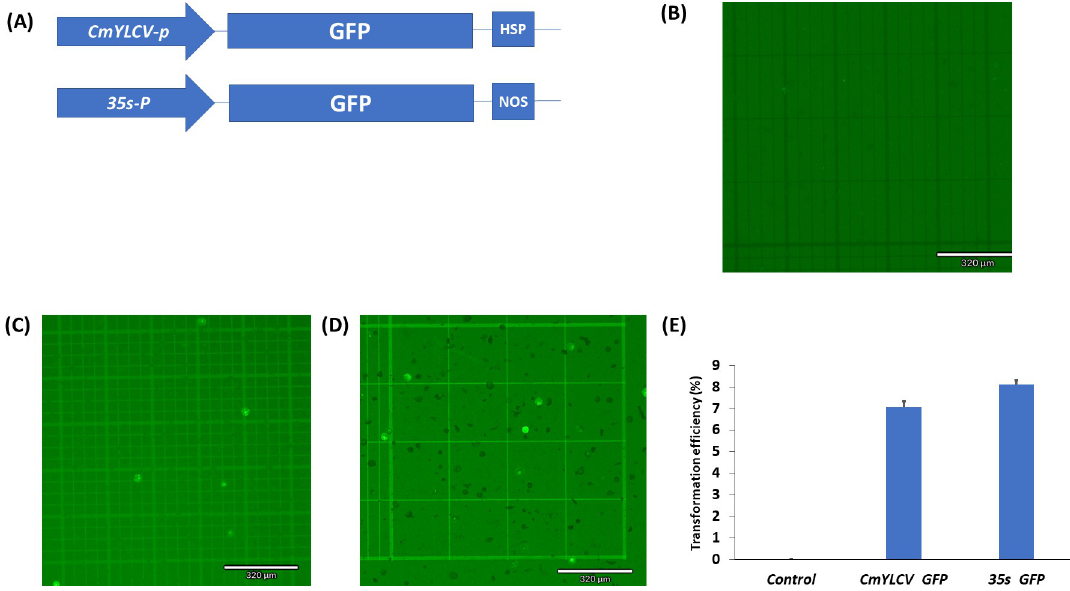
Fig 2. GFP expression under CmYLCV and 35S promoter in cowpea protoplasts. (A) CmYLCV promoter :GFP and 35S promoter :GFP vectors used in this study. (B) Control protoplasts (no GFP plasmid). (C) Protoplasts with GFP expression under CmYLCV promoter. (D) protoplast with GFP expression under 35S promoter. (E) The transformation efficiency (TE) of protoplasts transformed with CmYLCV:GFP and 35S:GFP plasmid. The protoplasts TE was evaluated after incubation in 40% PEG solution. Values represent means ± SE (n =